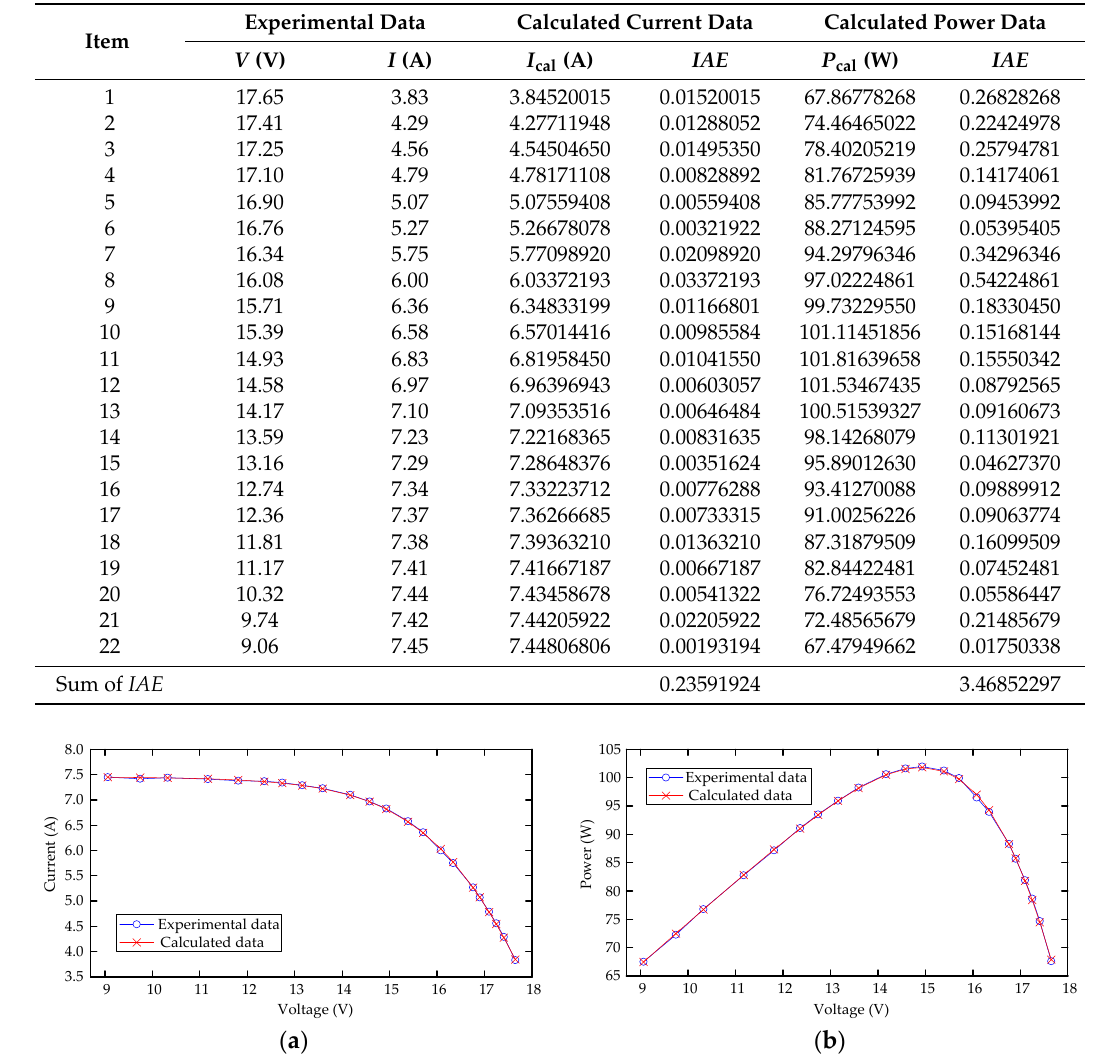
The calculated results of the proposed ImCSA for the PMM of polycrystalline STP6-120/36 panel.